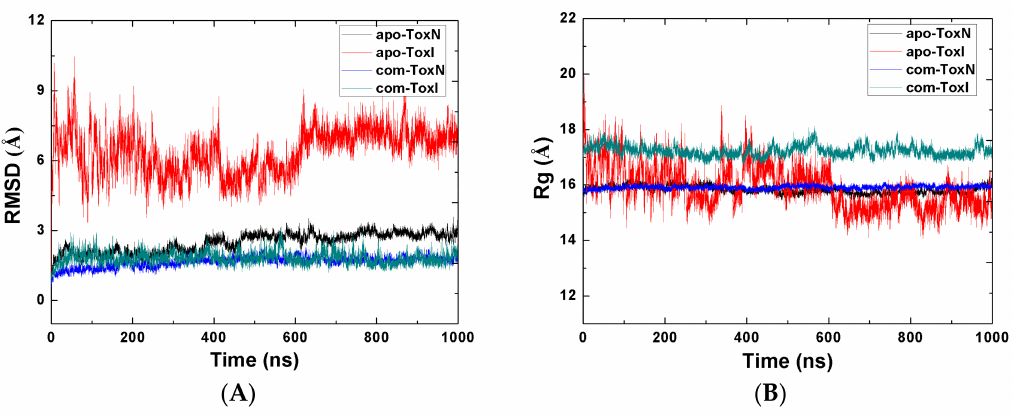
Figure 2. ( A ) The root mean square deviations (RMSDs) of the selected atoms with respect to their crystal structures as a function of molecular dynamics (MD) simulation time. ( B ) Radius of gyration as a function of MD simulation time. The prefix “apo” refers to the monomer form, and “com” refers to the complexed